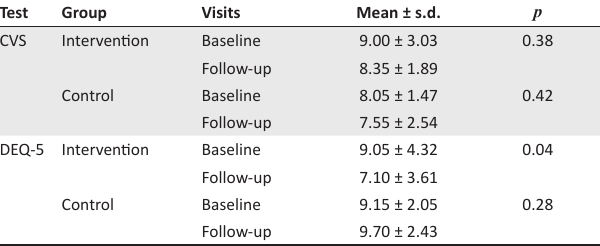
TABLE 1: Group means and standard deviations for Computer Vision Syndrome Questionnaire and Dry Eye Questionnaire 5 for baseline and follow-up visits for both intervention and control groups with the outcomes of paired t -test intergroup comparisons.